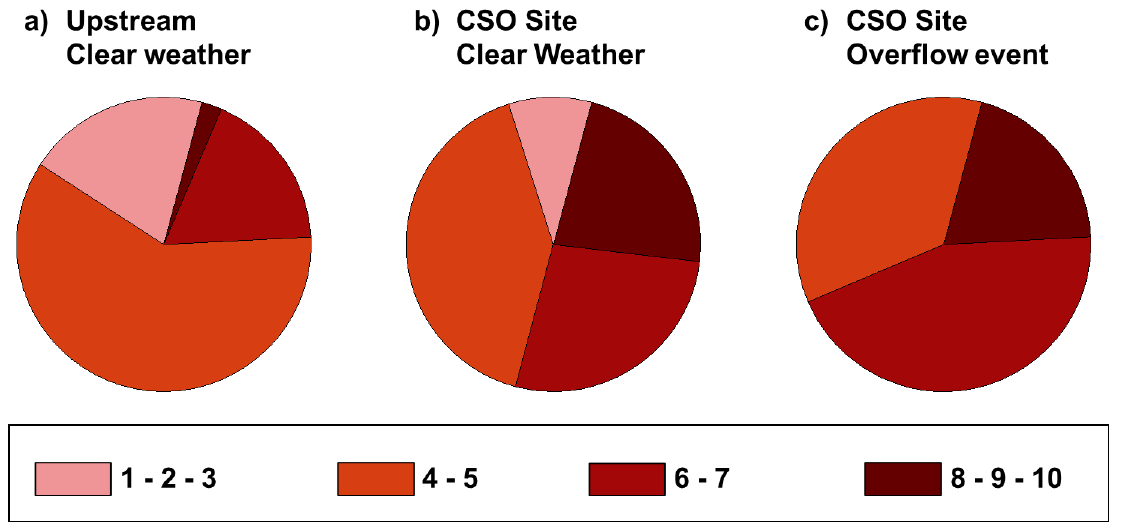
Figure 3. Fraction of isolates resistant to varying numbers of